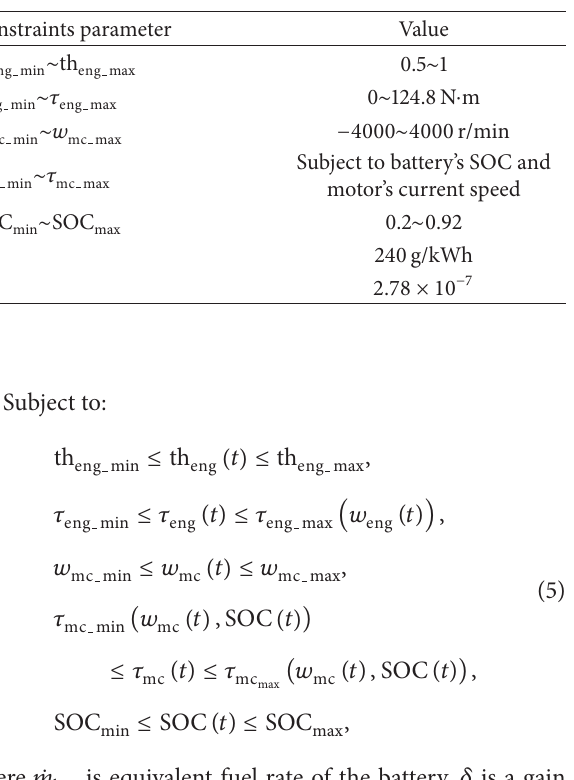
Table 2: Constraints parameter in optimal control